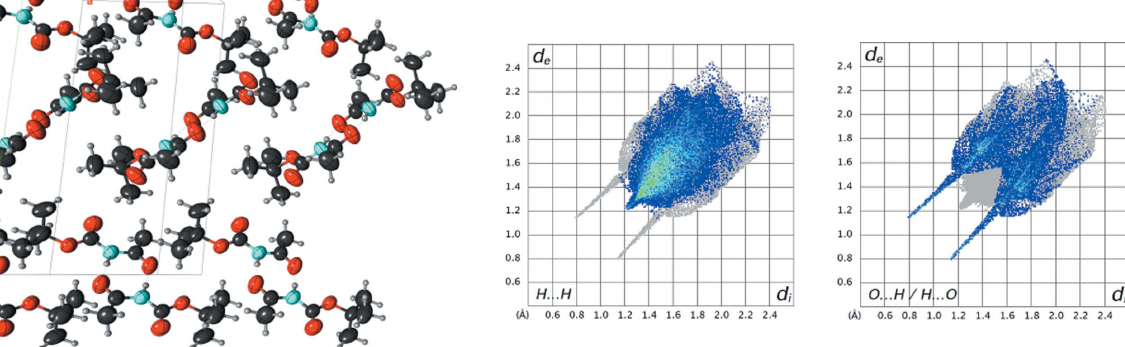
Figure 4 Two-dimensional fingerprint plots of the major contacts on the Hirshfeld